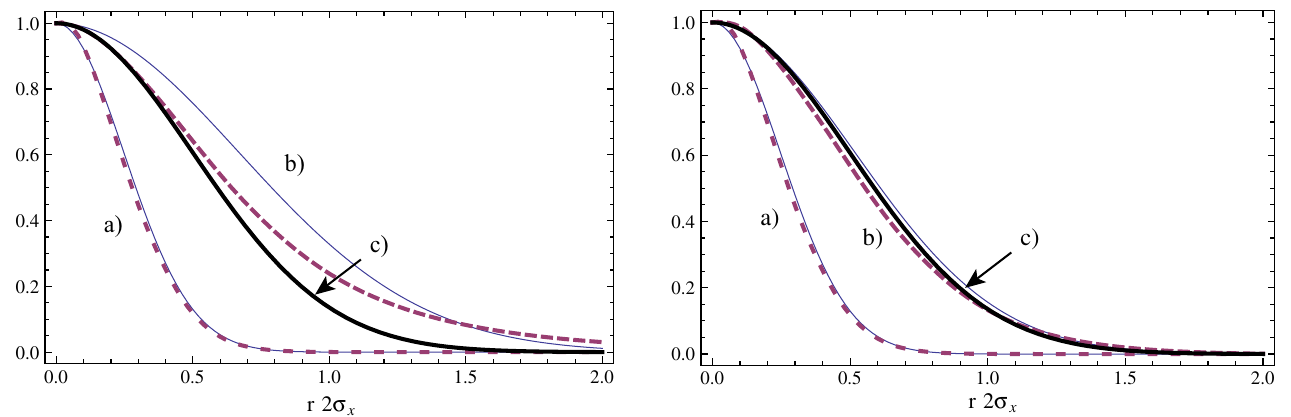
FIG. 9. Comparison of the transverse normalized intensity mode profile between simulation and theory for two cases: ¼ 0 : 04 , (cid:5) ¼ 0 , (cid:1) (cid:2) ¼ 0 : 23 where the mode profile (a) (cid:5) d (cid:3) p ¼ 0 : 45 , (cid:5) ¼ 0 , is contained within the e-beam, and (b) (cid:5) d (cid:3) (cid:1) ¼ 0 : 42 where the mode profile approximately matches (cid:2) p the e-beam. GENESIS results are represented as dashed lines while the solid, blue lines represent results from theory for both cases. The e-beam is shown in black (c).